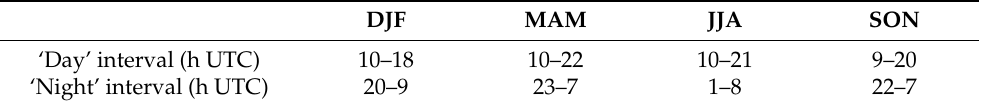
Figure 3. ( a , d , f , i , k , n , p , s ) Hourly averages of horizontal wind speed and direction vertical profiles for all seasons; ( b , g , l , q ) daytime and night-time averaged wind speed profiles U H and ( c , h , m , r ) their respective standard deviations Δ U H ; ( e , j , o , t ) daytime and night-time averaged wind direction profiles. Table 2. Selected hours for ‘Day’ and ‘Night’ time intervals for the averaged profiles at each season. DJF ‘Day’ interval (h